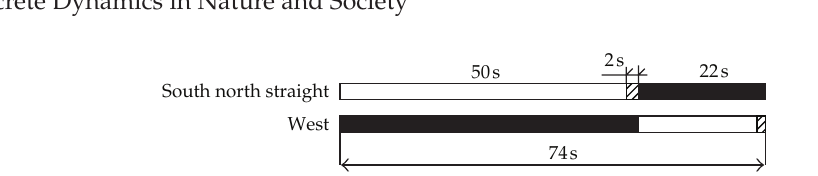
Figure 9: Distribution diagram of signal timing of T-shaped intersection B. Table 1: The average tra ffi c arrival rates of C, A, and B (cid:4) person/s (cid:5) . Crosswalk Direction Crosswalk